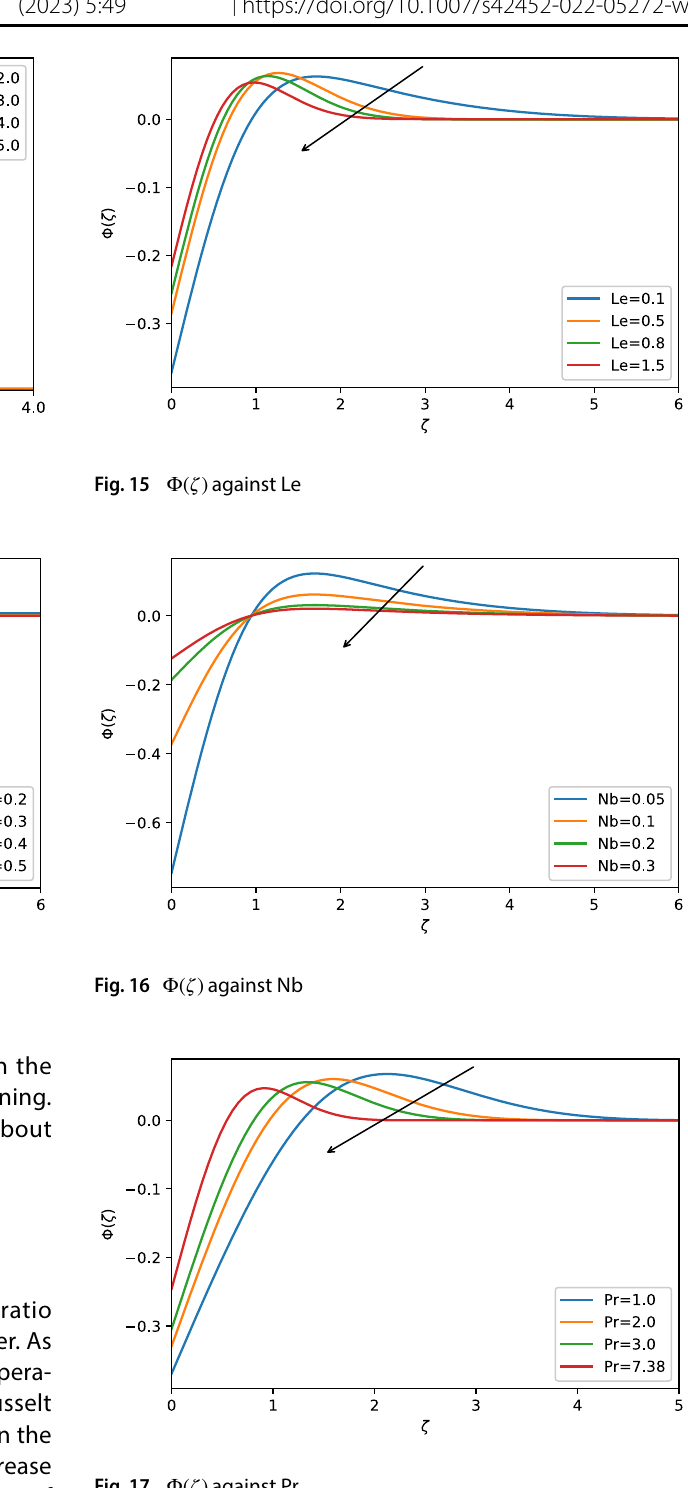
Fig. 17 Φ( 𝜁 ) against